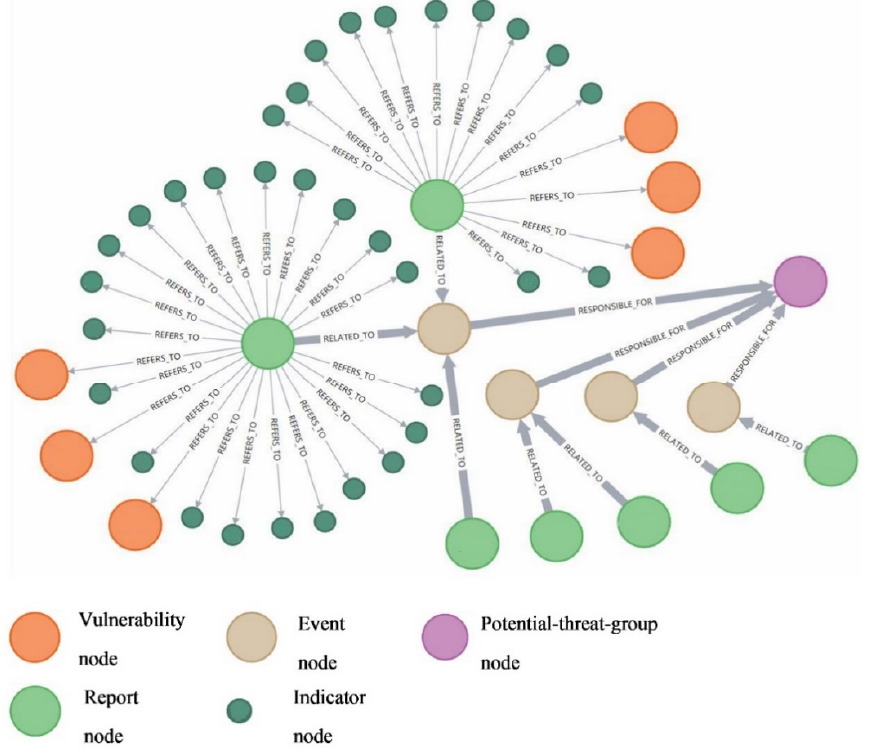
Figure 9. A generated Potential-threat-group node.